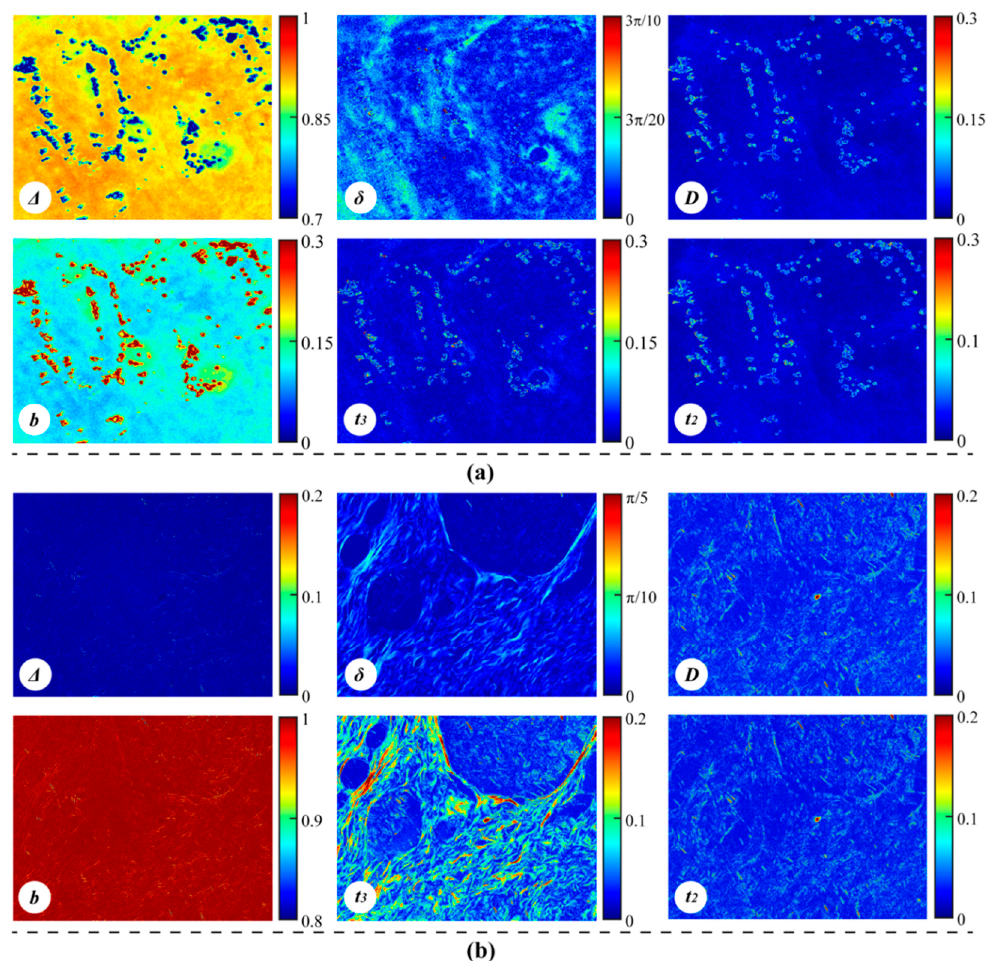
Figure 7. Mueller matrix derived parameters of: ( a ) ex vivo porcine colon tissue; all the color scales are set to 0.3 times the codomains of the parameters. It should be noticed that there are areas with abnormally small values of Δ and large values of b , which result from the specular reflection induced pixel saturation. ( b ) Human breast invasive ductal carcinoma tissue: 12 μ m-thick, unstained, and dewaxed; all the color scales are 0.2 times the codomains of the parameters.